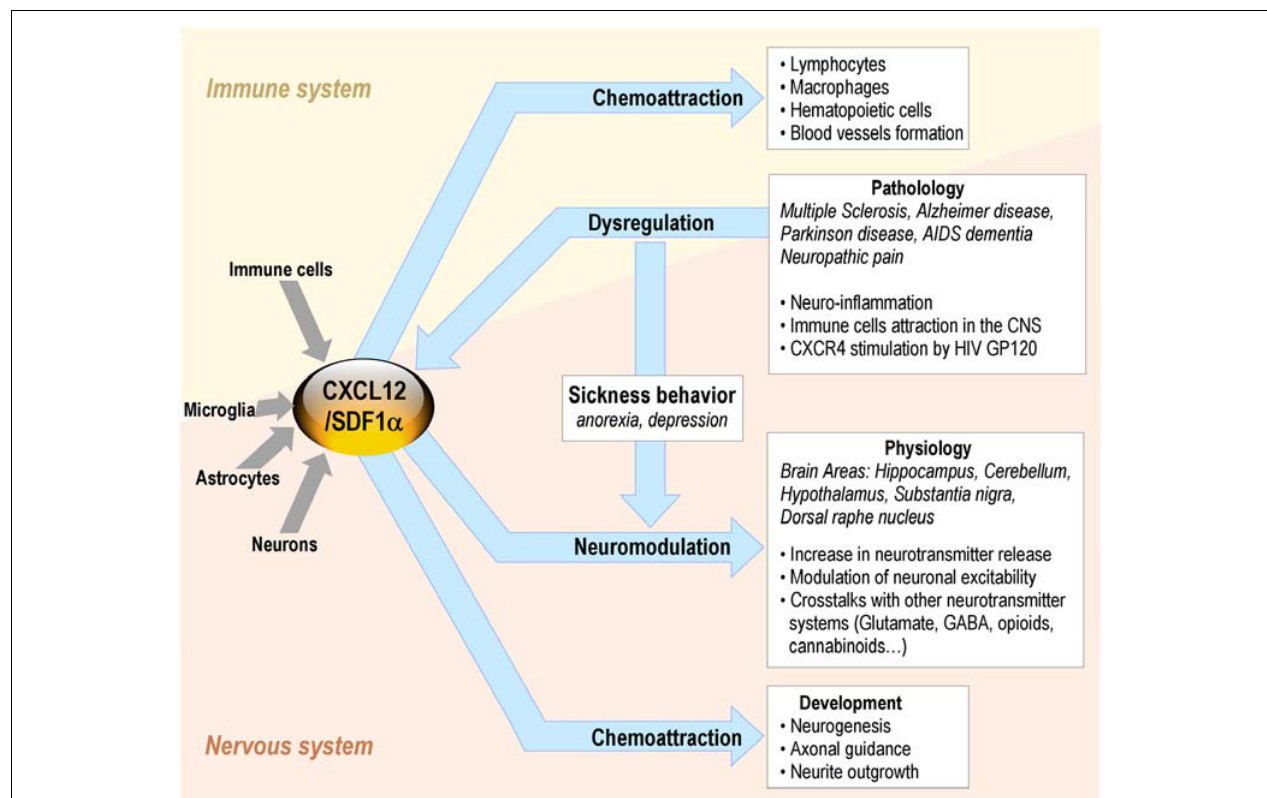
FIGURE 2 | CXCL12 roles in the brain-immune system cross-talk in non-pathological and pathological conditions.